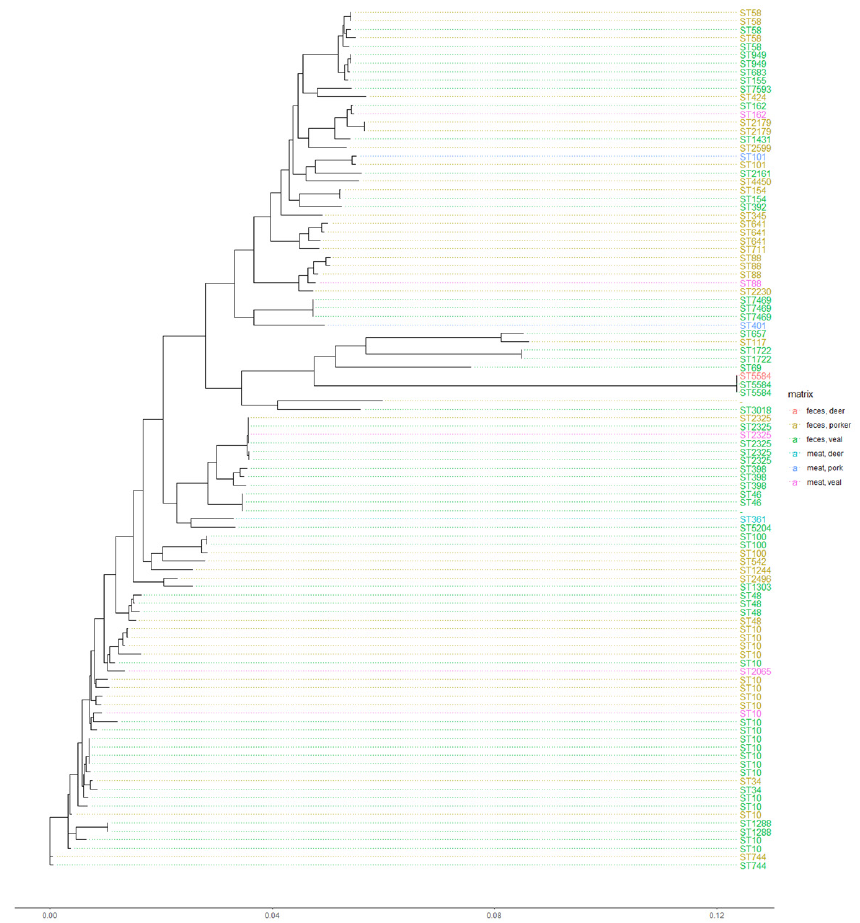
Figure 2. Phylogenetic relationship of (fluoro)quinolone-resistant and qnr -positive E. coli with metadata based on codon and protein differences, presented in a maximum-likelihood tree. The respective sequence type (ST) of the E. coli is shown as geom_tiplab and connected with dotted lines. The ST as well as the dots are coloured according to the matrix code of the recovered E. coli .